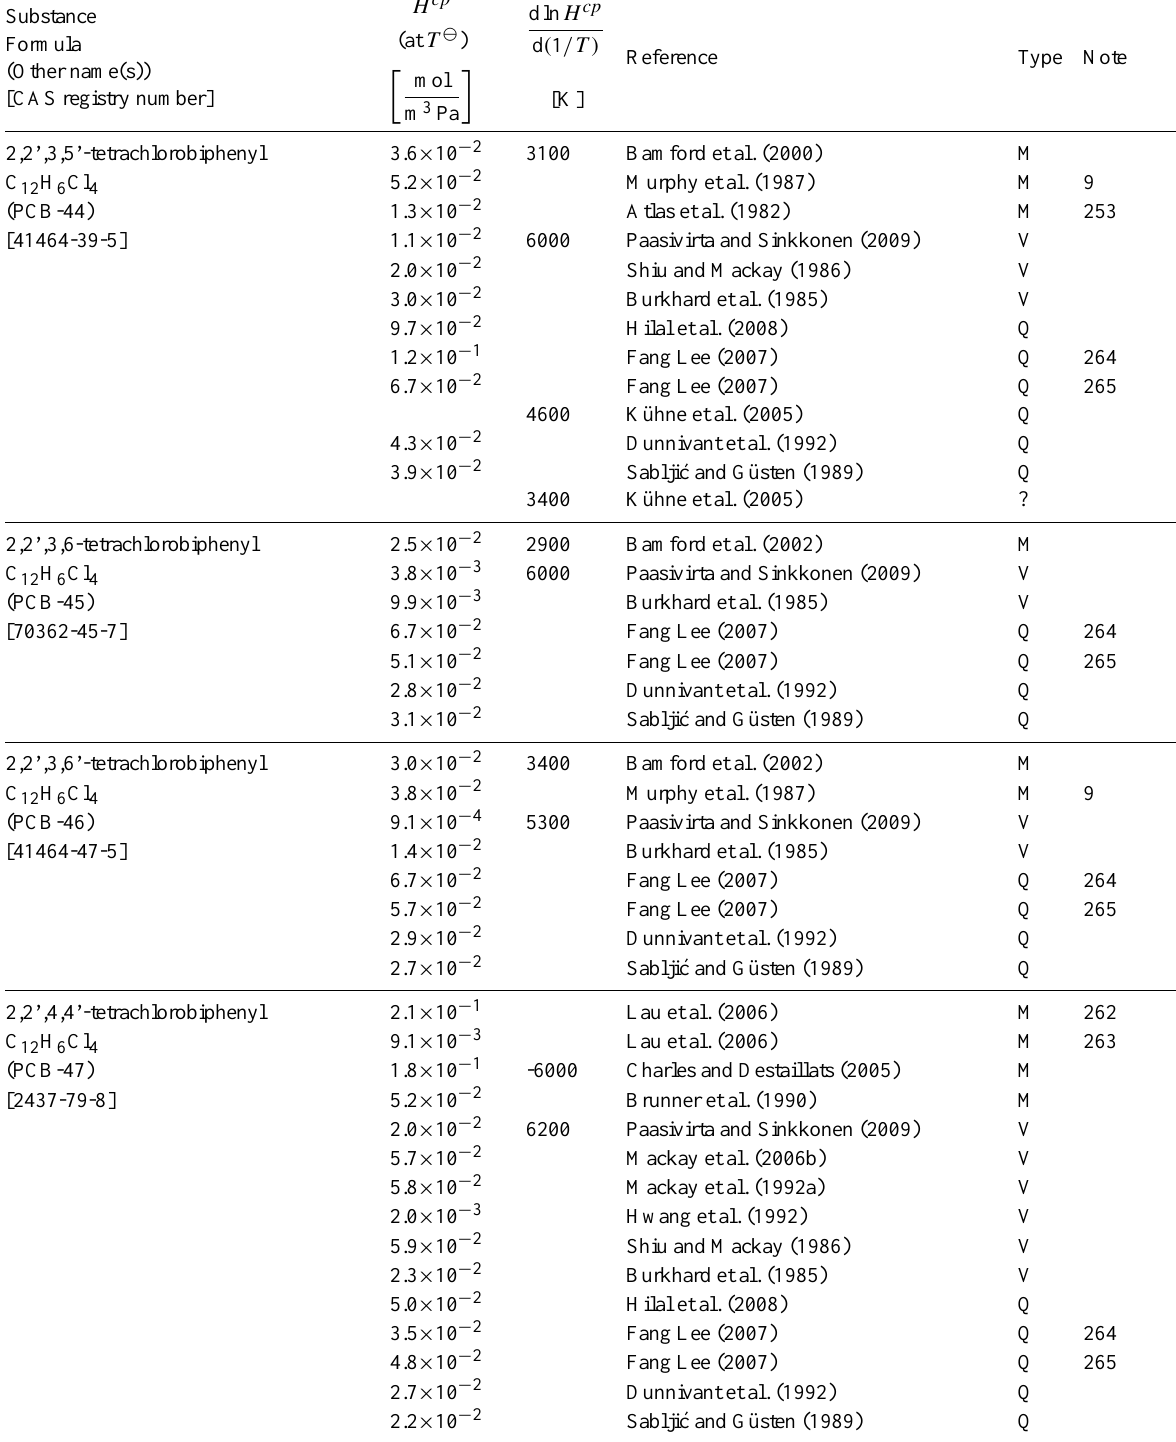
Table 6: Henry’s law constants for water as solvent